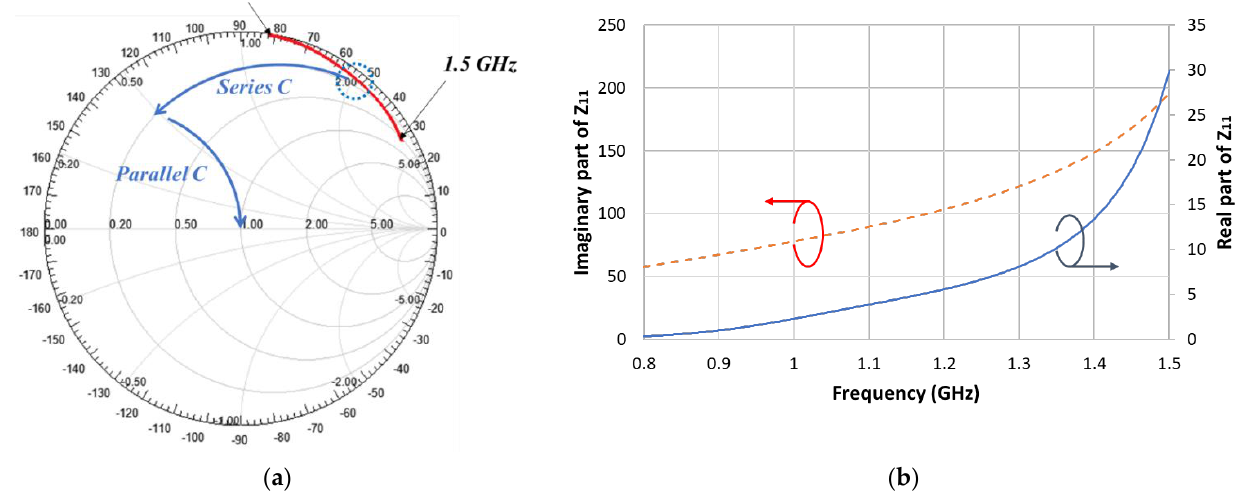
Figure 2. Simulated antenna impedance without matching circuit ( a ) Smith chart, ( b ) real and imaginary parts. Matching should be applied for the capacitor values to match at the lowest and high- est resonant frequencies of 0.9 and 1.4 GHz, respectively. For resonance at 1.4 GHz, the values of the series ( C S ) and parallel ( C P ) capacitors should be 0.9 and 3 pF, respectively. For resonance at 0.9 GHz, the respective values should be 3 and 20 pF. These values for